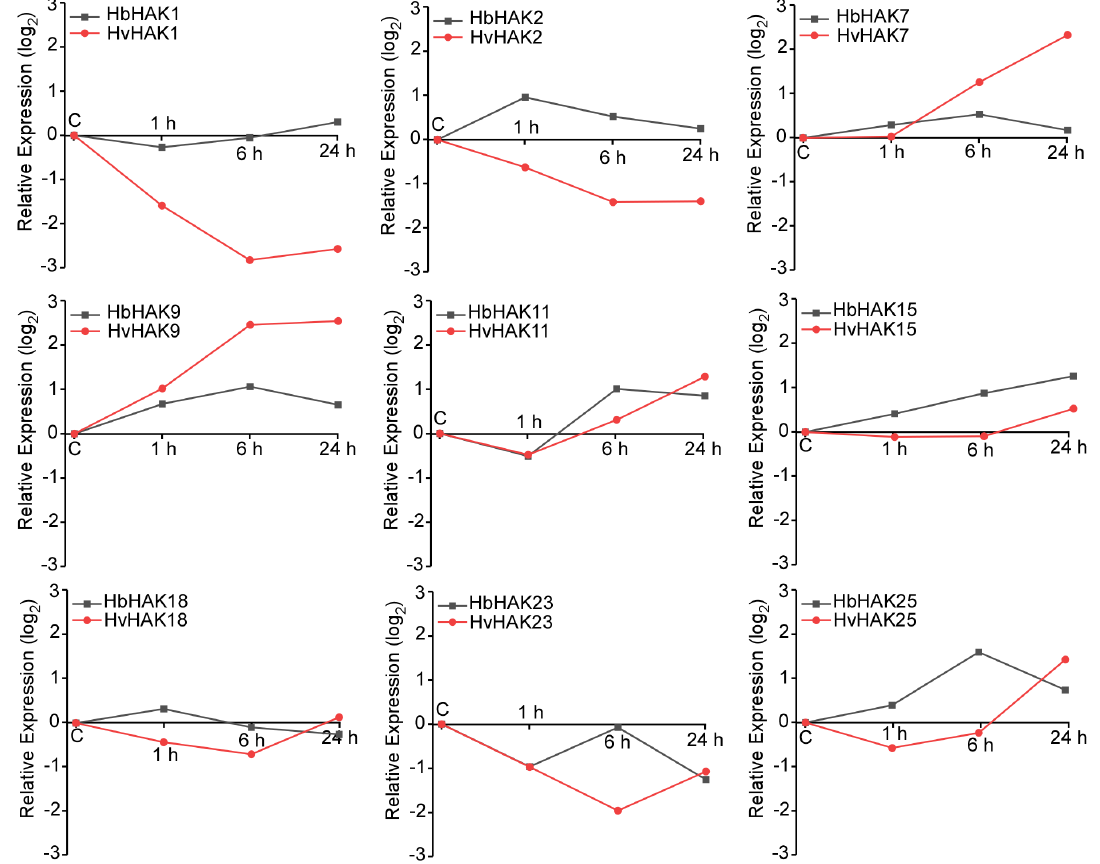
Figure 2. Selected HAK/KUP/KT genes with different expression pattern from barley. The expression level in different time course was compared with no-NaCl treatment control. The data were using a criterion of absolute log2(fold-change) of the relative expression levels.